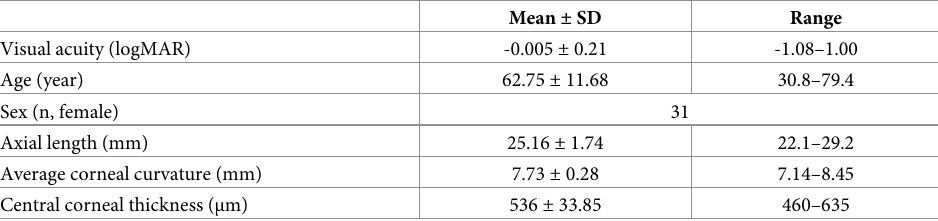
Table 1. Demographics and ocular characteristics of patients (POAG, n =